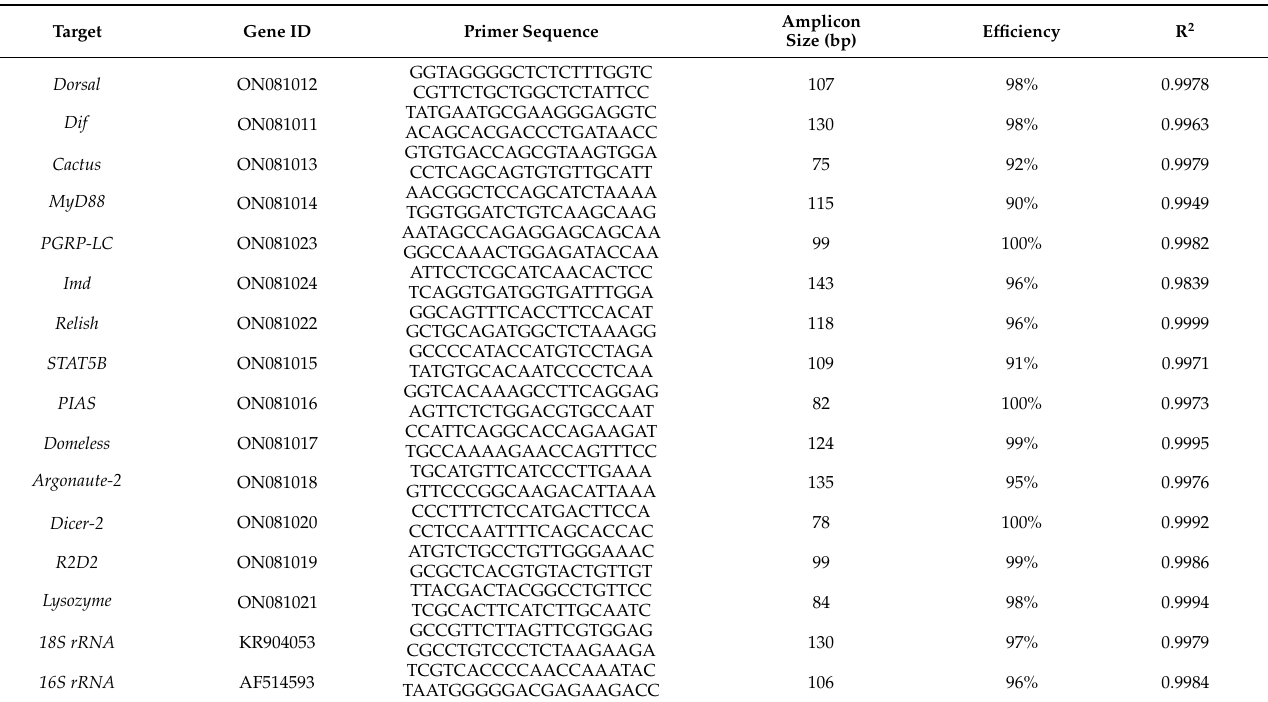
Table 1. Primers used to quantify gene expression in Gryllodes sigillatus adults in this